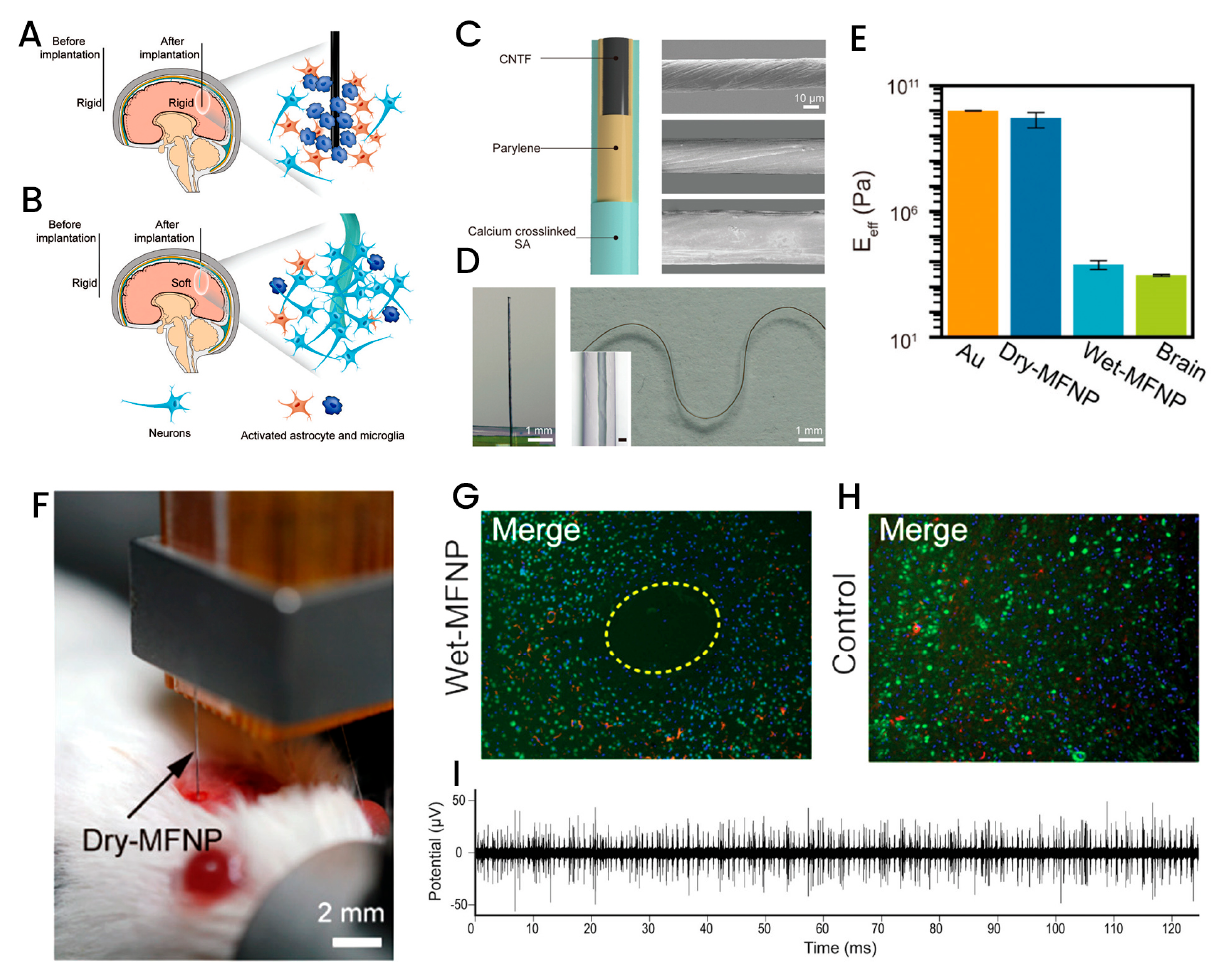
Figure 7. Implantable MFNPs-based module as an electronic interface for brain sensing. ( A , B ) Com- parison between direct implantation of a rigid probe and a soft MFNP module in the brain. ( C ) Demon- stration of a dry − MFNP composition. ( D ) Picture a wet-MFNP. ( E ) Effectiveness of elastic modules (Au wire, dry − MFNP, wet − MFNP) and mouse brain via indentation measurement. ( F ) MFNP implantation in a mouse brain. ( G , H ) Immunohistochemistry analysis of brain tissues implanted with an MFNP compared to a control (no implant). The yellow dashed circle shows the position of the MFNP. ( I ) MFNP − based recording of endogenous activity. Reproduced with permission from ref. [68]. ©2020 The Royal Society of Chemistry.